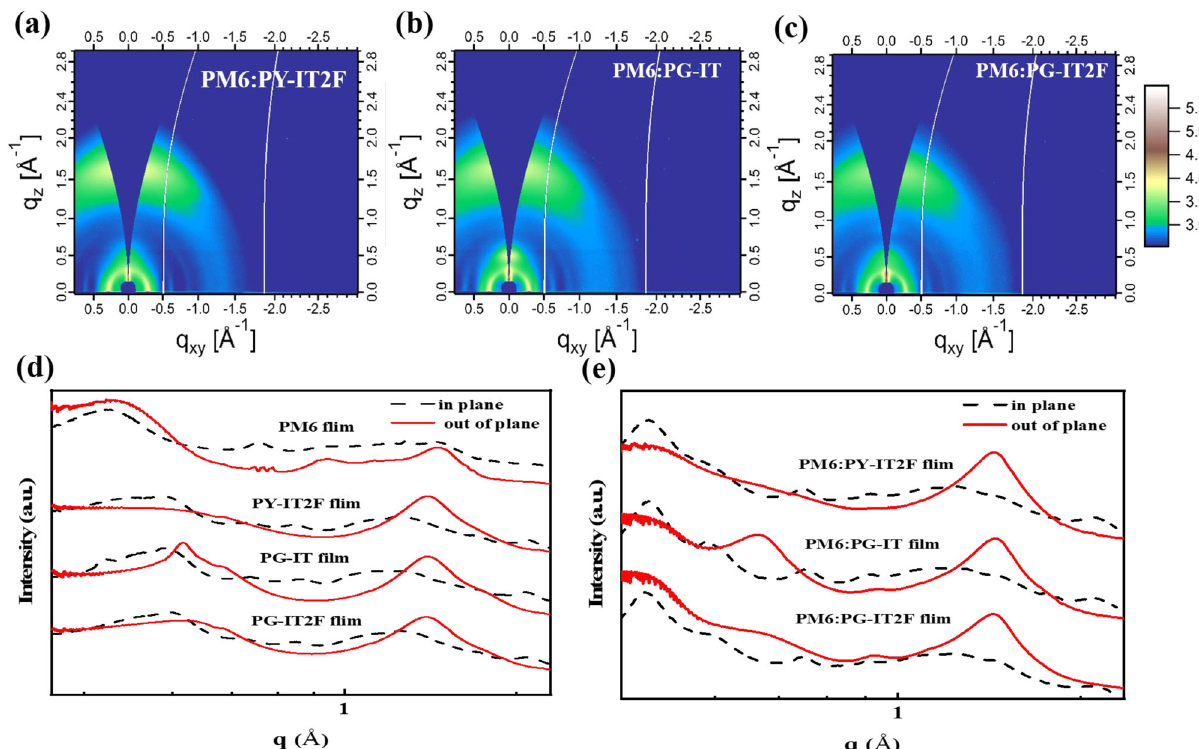
Fig.5|ResultsofGIWAXSmeasurements.a 2DGIWAXSpatternsoftheoptimized blend fi lms of PM6:PY-IT2F, b 2D GIWAXS patterns of the optimized blend fi lms of PM6:PY-IT2FPM6:PG-IT,and c 2DGIWAXSpatternsoftheoptimizedblend fi lmsof